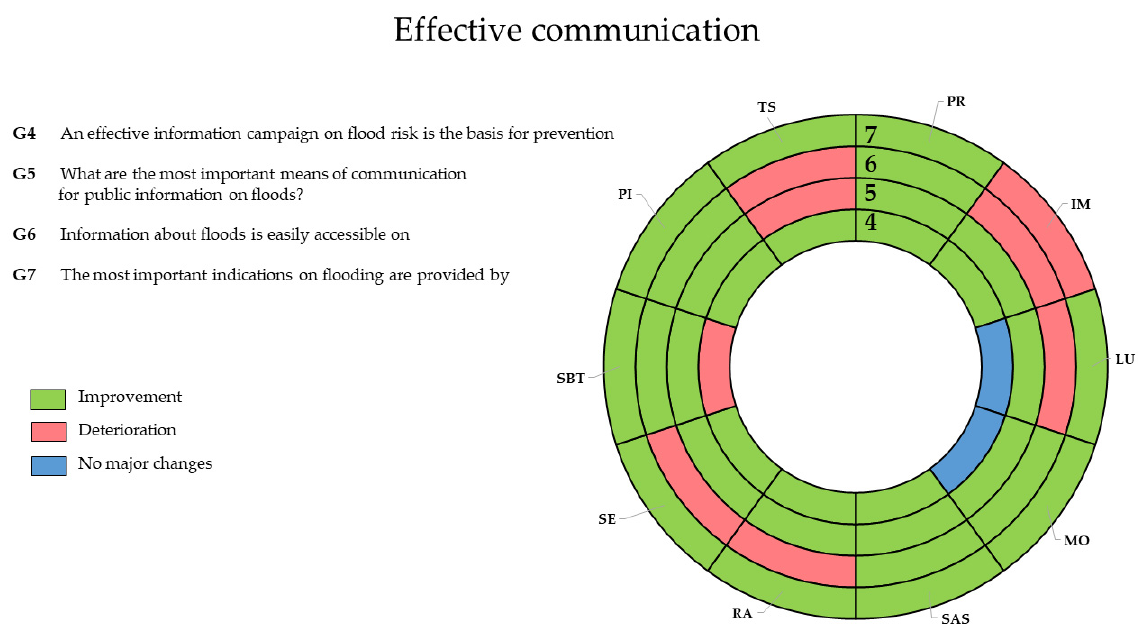
Figure 3. Representation of the effect of the LIFE PRIME project activities in shaping the effectiveness of communications in the ten pilot areas (PR = Poggio Renatico; IM = Imola; LU = Lugo; MO = Mordano; SAS = Sant’Agata sul Santerno; RA = Ravenna; SE = Senigallia; SBT = San Benedetto del Tronto; PI = Pineto; TS = Torino di Sangro). Each question is represented as a circle numbered from G4 to G7 and colors represent increase (green), decrease (pink), or absence of a change (blue) between the ex-ante and ex-post phases.